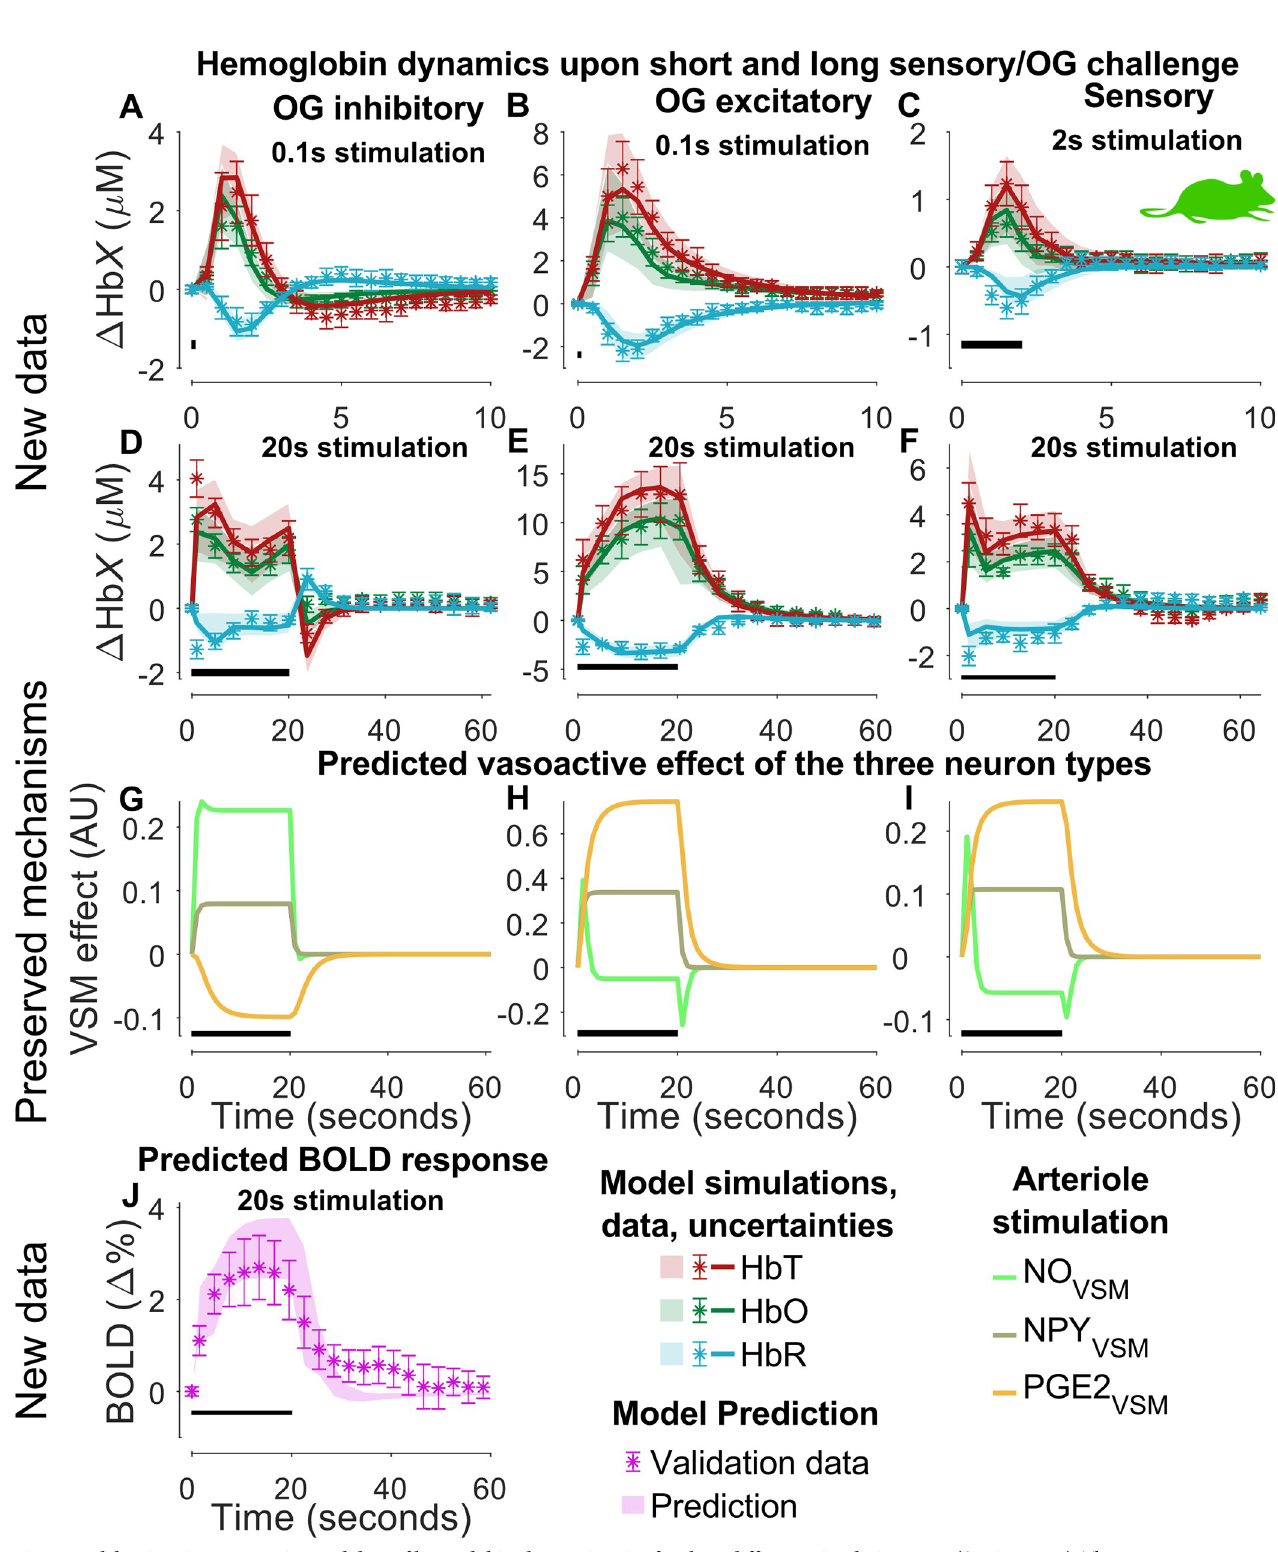
Fig 5. Model estimation to experimental data of hemoglobin changes in mice for three different stimulation types (Section 2.1.4). The experiment features optogenetic (OG) activation of inhibitory (A & D) and excitatory (B & E) neurons, and sensory stimulation (C & F). For each stimuli type, a short stimulus (OG: 100 ms of light (A-B); Sensory: 2 s I) and a long stimulus (OG: 20 s (D-E); Sensory: 20 s (F)) was used. This is denoted with the black bar in the